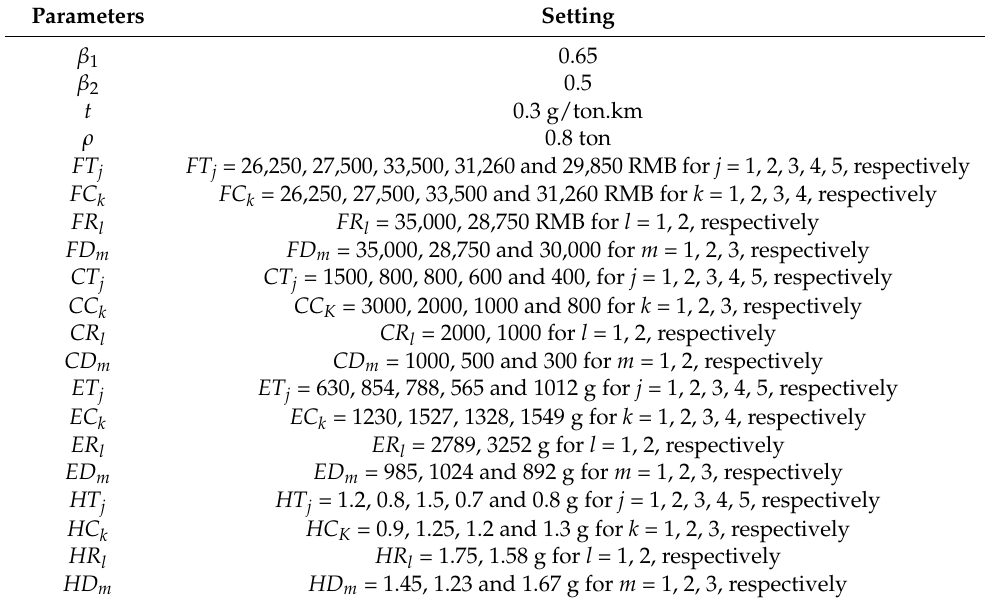
Table 5. The main input parameters.